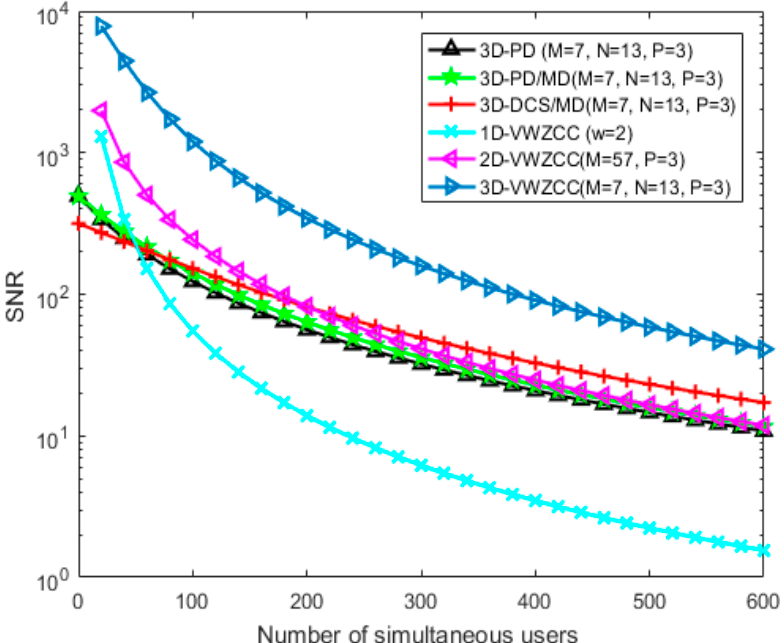
Figure 4. SNR against number of simultaneous users when the effective source power P sr = − 10 dBm and data rate R b = 1.25 Gbps.